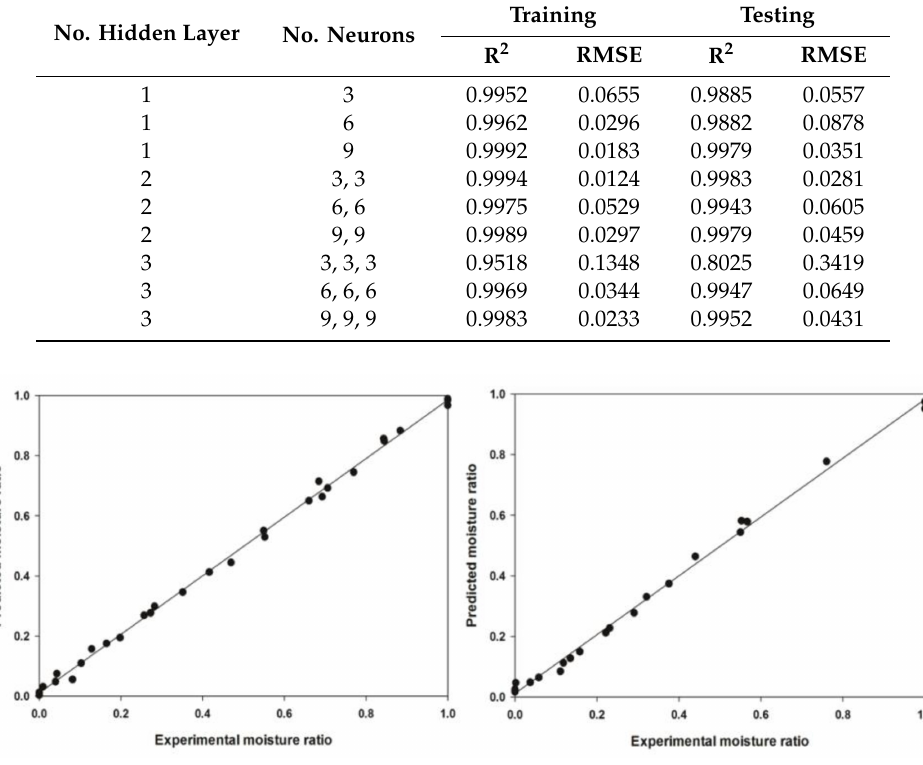
Figure 6. Predicted and experimental moisture ratio using VD from training and testing data set of ANN